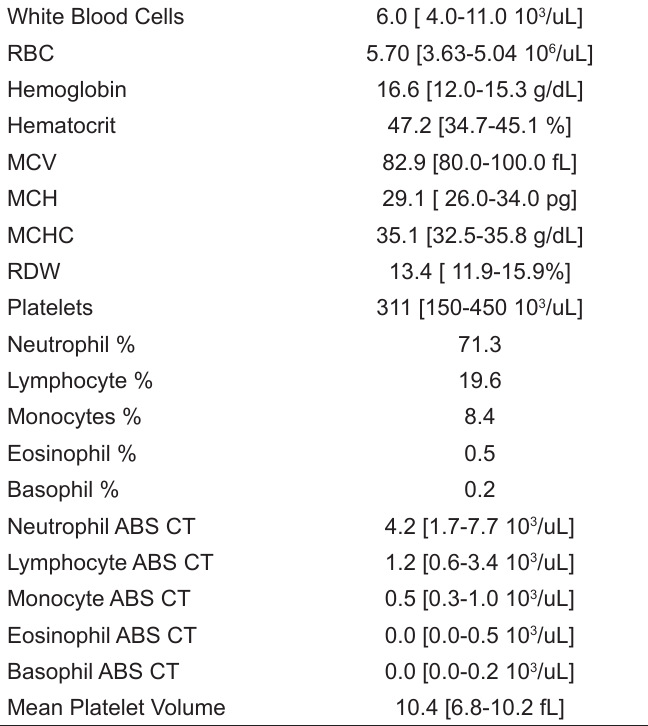
Table 1. Complete blood count with differential of an 18-year-old pregnant patient with emesis.